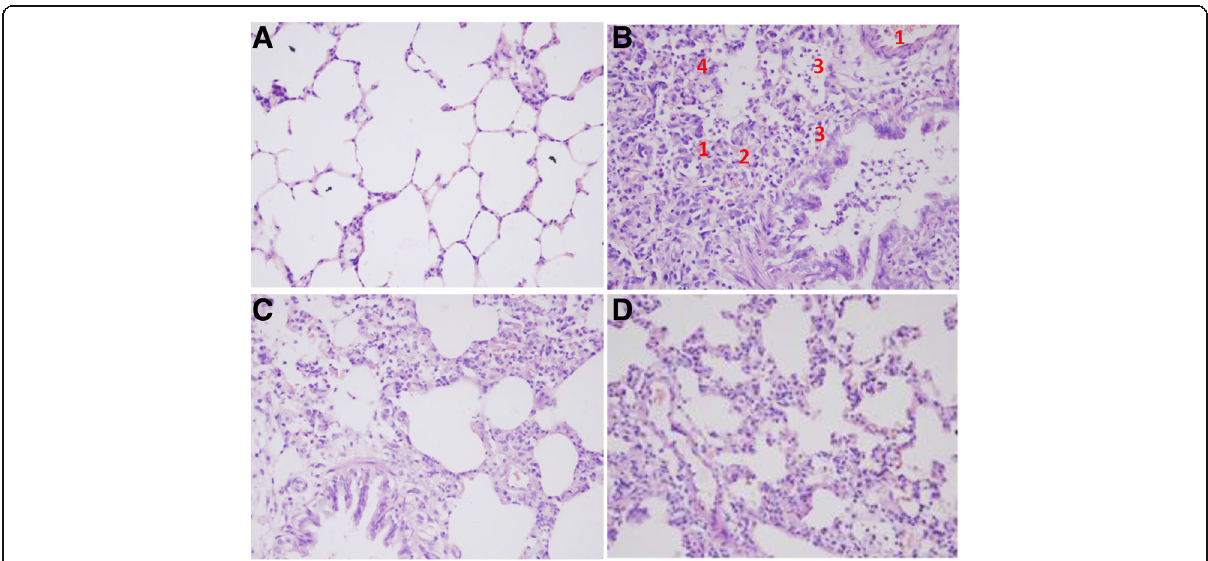
Fig. 1 Pulmonary histomorphology in each group (H&E stained). ( a ) control group ( b ) model group ( c ) DSQ group; ( d ) LVX group. 1: alveolar